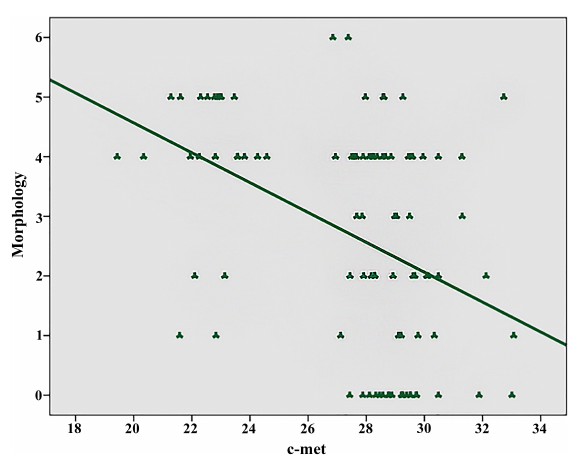
Fig. 4. Negative correlation between sperm morphology per- centage and c-Met expression level in the total cohort (r = – 0.441, p = 0.001).